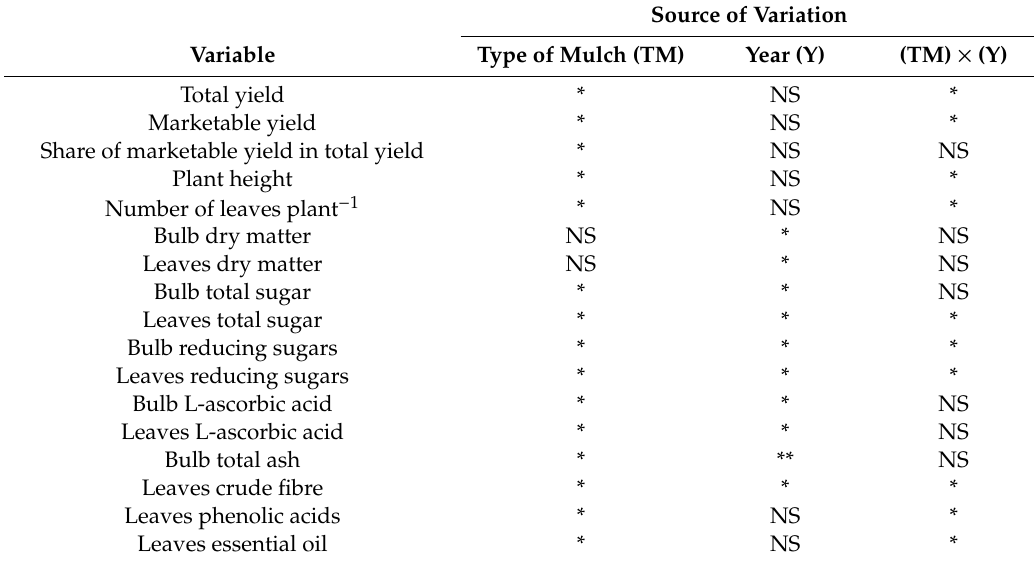
Table 2. Summary of statistical significance from analysis of variance.